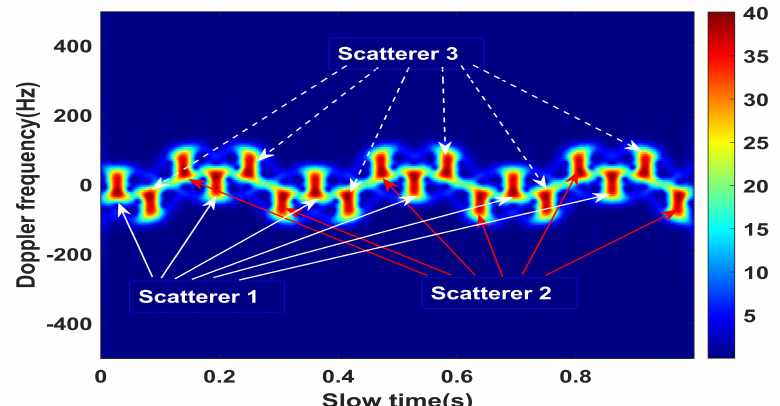
Figure 9. Scatterer separation in the time-frequency